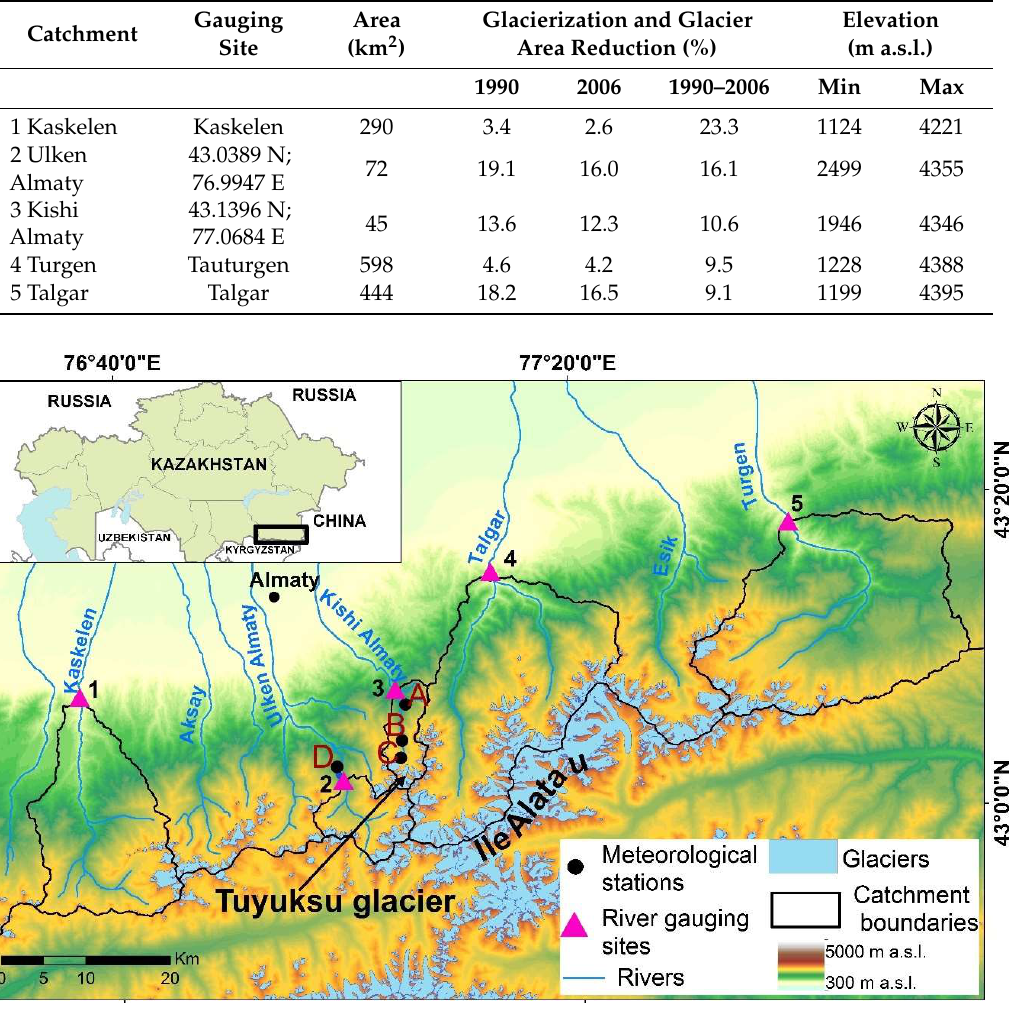
Figure 1. Study area. Letters refer to the location of meteorological stations: A—Chimbulak, B—